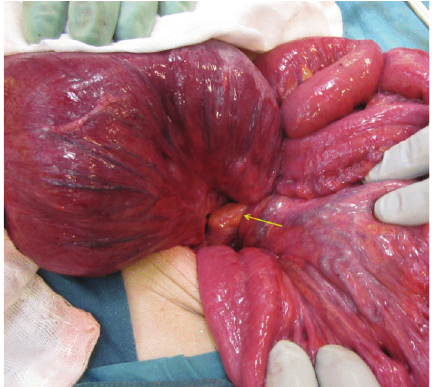
Figure 3: The enlarged pouch twisted around the long axis of its mesentery (arrow).